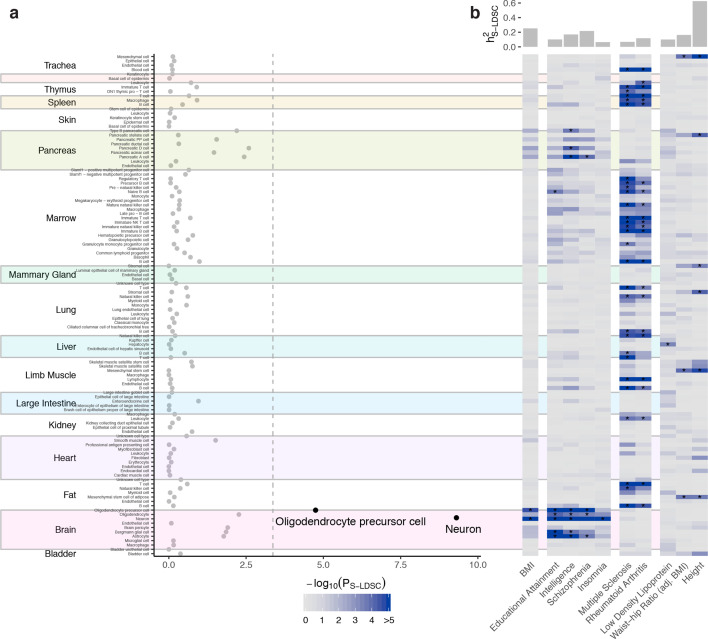
Cell type prioritization across 17 tissues highlights a key role of the brain in obesity.(a) Prioritization of 115 Tabula Muris cell types identified two cell types from the brain as significantly associated with BMI, namely oligodendrocyte precursor cells and neurons (shown in black; Bonferroni significance threshold, PS-LDSC <0.05/115). (b) Heatmap of cell type prioritization for multiple GWAS traits. BMI results (first column) are the same as in panel (a) and projected onto the heatmap. The four brain-related traits (second column) were associated with cell types in the brain, the two immune traits (third column) were associated with immune cells, and anthropometric traits (fourth column) were associated with mesenchymal stem cells, which are progenitor cells for muscle, bone and fat. Asterisks (*) mark cell types passing the per-trait Bonferroni significance threshold. The top bar plot shows the estimated trait heritability. An overview of the GWAS files used in this work are available in the Figure 2—source data 1, metadata for the Tabula Muris dataset are available in Figure 2—source data 2 and the CELLECT results for the Tabula Muris dataset are available in Figure 2—source data 3. S-LDSC, stratified-linkage disequilibrium score regression; h2S-LDSC, trait SNP-heritability.Figure 2—source data 1.GWAS overview.Figure 2—source data 2.Tabula Muris metadata.Figure 2—source data 3.Tabula Muris CELLECT results.